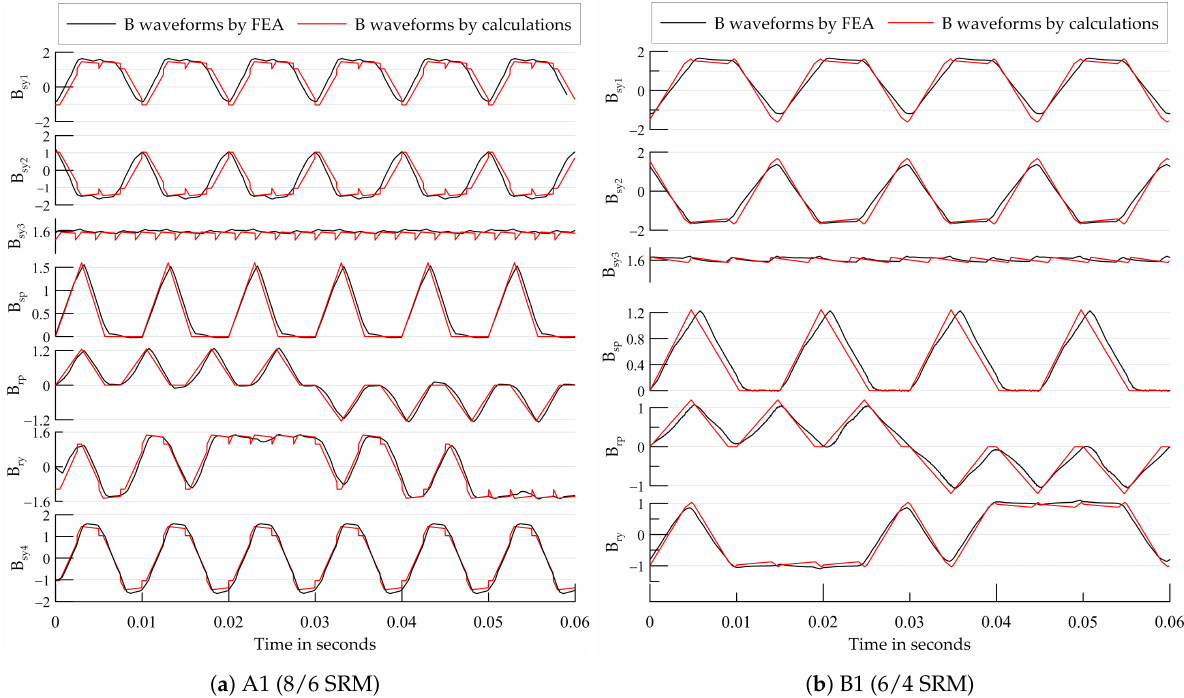
Figure 12. The flux density waveforms in all sectors of optimal SRM designs A1 (8/6 SRM) and B1 (6/4 SRM) for one revolution at 1000